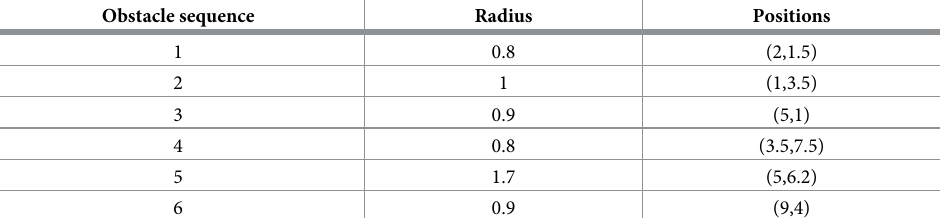
Table 4. The obstacle data in the static environment (6 obstacles). Obstacle sequence